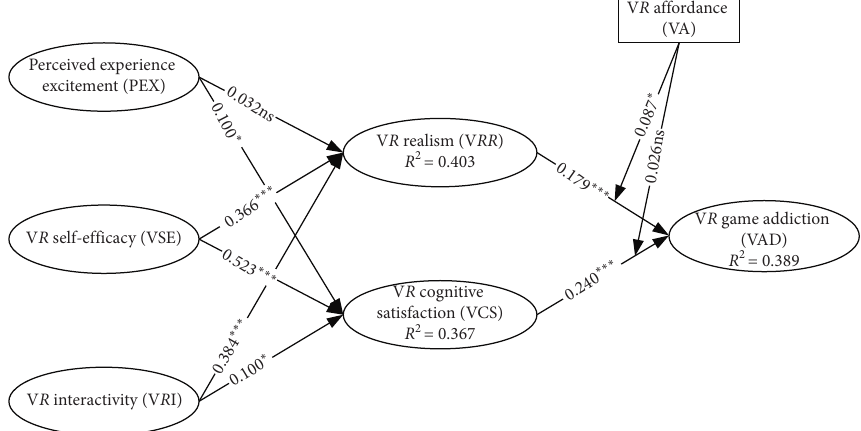
Figure 1: Graphical view of the path analysis of the proposed